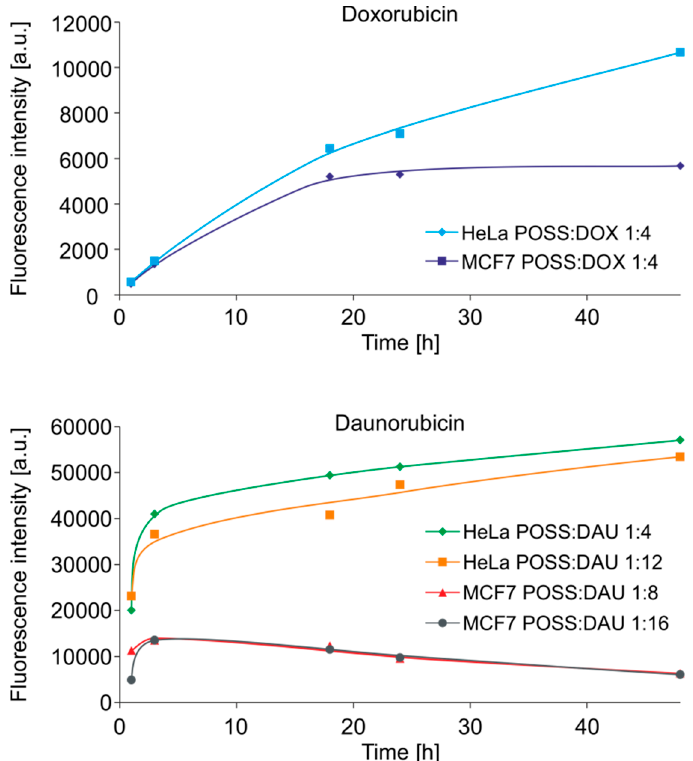
Figure 8. The cellular uptake of selected POSS:DOX and POSS:DAU complexes at different molar ratio by human cervical cancer endothelial (HeLa) and human breast adenocarcinoma (MCF-7) cells. Abbreviations: DAU, daunorubicin; DOX, doxorubicin; POSS, polyhedral oligomeric silsesquioxanes.